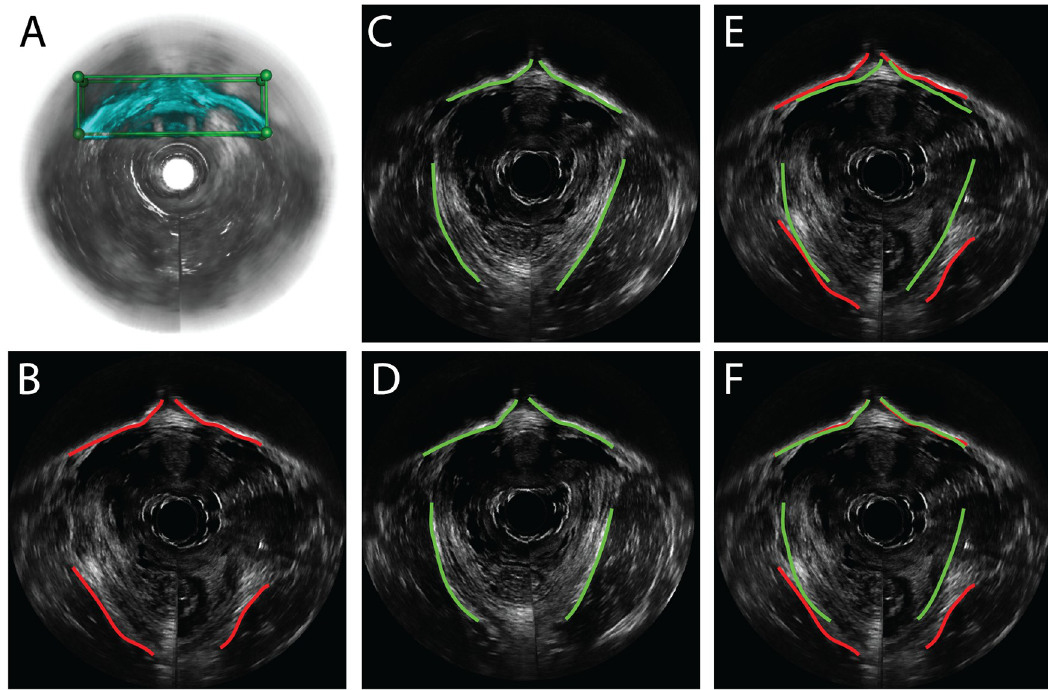
Fig 4. Intensity-based volumetric registration on pubic bone VOI. (A) A cubic VOI enclosing the public bone was defined in the fixed image volume (green grid). The pubic bone was rendered in cyan simply to highlight the bone dimensions. (B) One slice image from fixed image volume with pubic bone and muscle boundaries. (C) Corresponding image slice before registration in the moving image volume. (D) Corresponding image slice after registration in the transformed moving image volume. (E) Pubic bone and muscle boundaries comparison before registration, the initial boundaries are not matched between fixed and moving images. (F) Pubic bone and muscle boundaries comparison after registration. The pubic bone boundaries are better aligned demonstrating the effectiveness of first stage